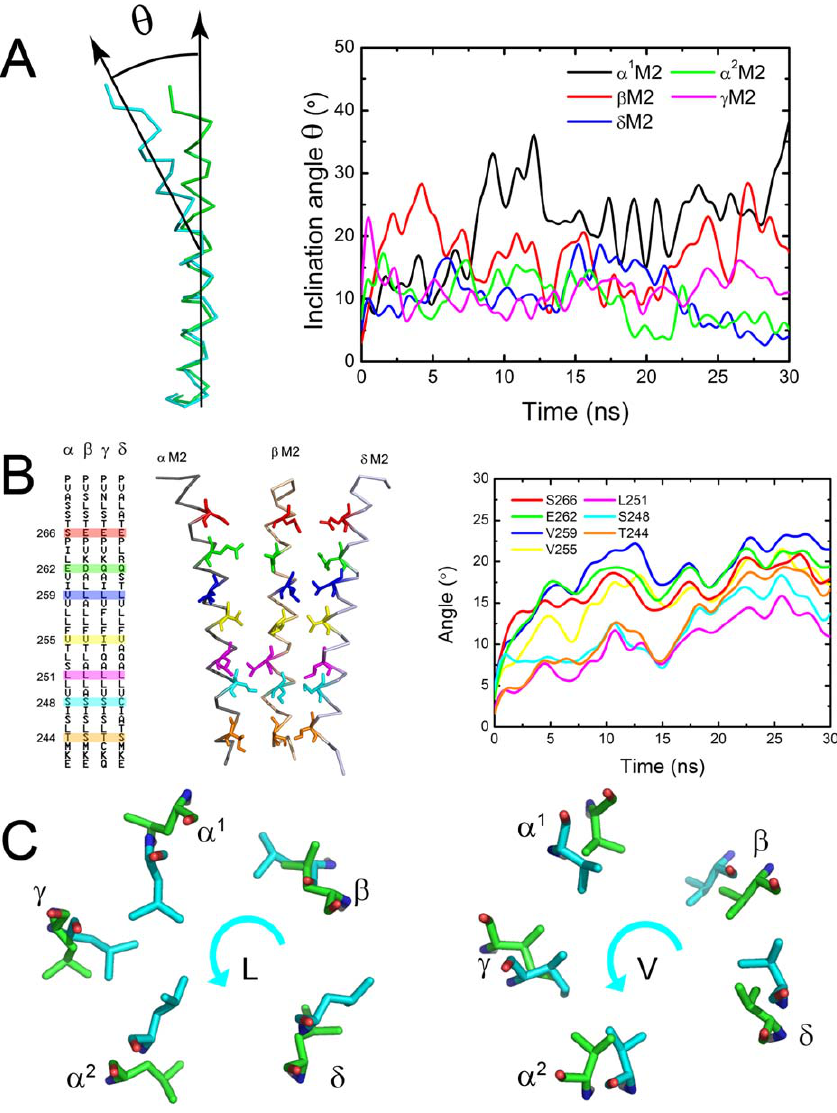
Figure 5. Dynamics of the M2 Helices (A) Bending vibrations of the M2 helices represented by changes of inclination angle along the CMD trajectory. (B) Schematic representation for the positions of some important residues throughout the M2 helices (left). Rotation angle profiles of the important residues (right). (C) Rotations of the L- and V-rings. The anticlockwise rotations of L- and V-rings are represented by the conformational superposition between the starting structure (green) and final structure of the CMD simulation (cyan) on the